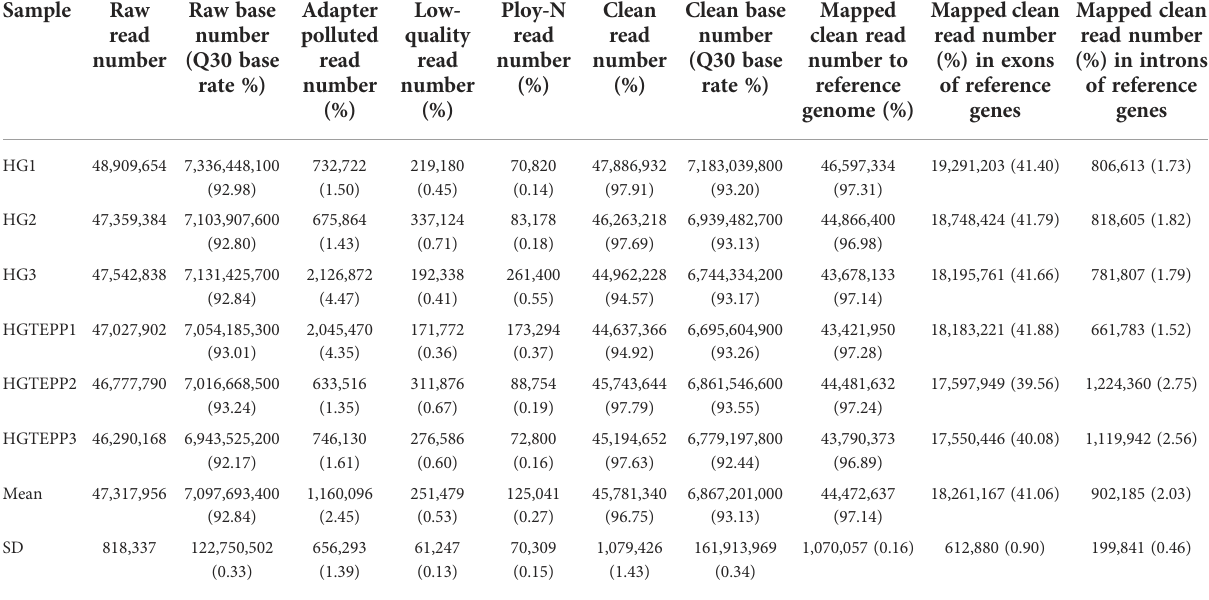
TABLE 1 Statistics of quality control and alignment to human reference genome (GRCh38.p13).